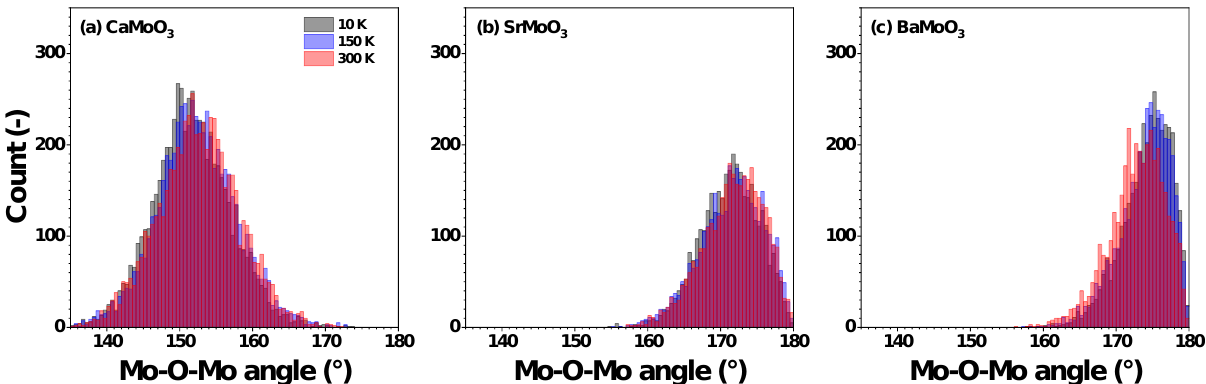
Figure 7. Histograms of inter-octahedral Mo–O–Mo angles—angular distribution functions (ADFs)— in polycrystalline ( a ) CaMoO 3 , ( b ) SrMoO 3 , and ( c ) BaMoO 3 at 10 K, 150 K, and 300 K. See text for